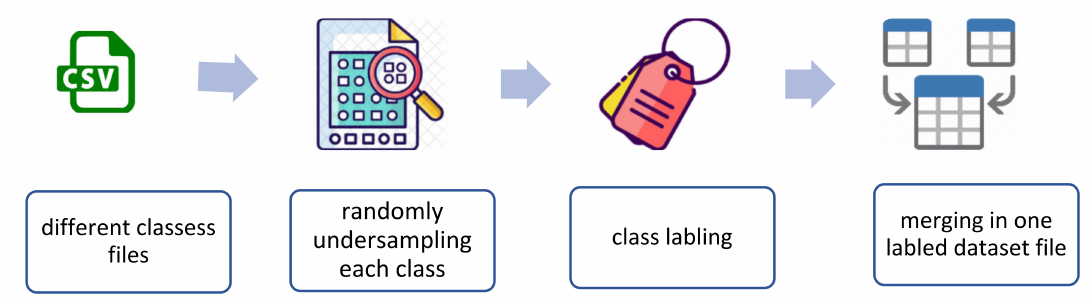
Figure 10. The process of undersampling and formulating the used balanced